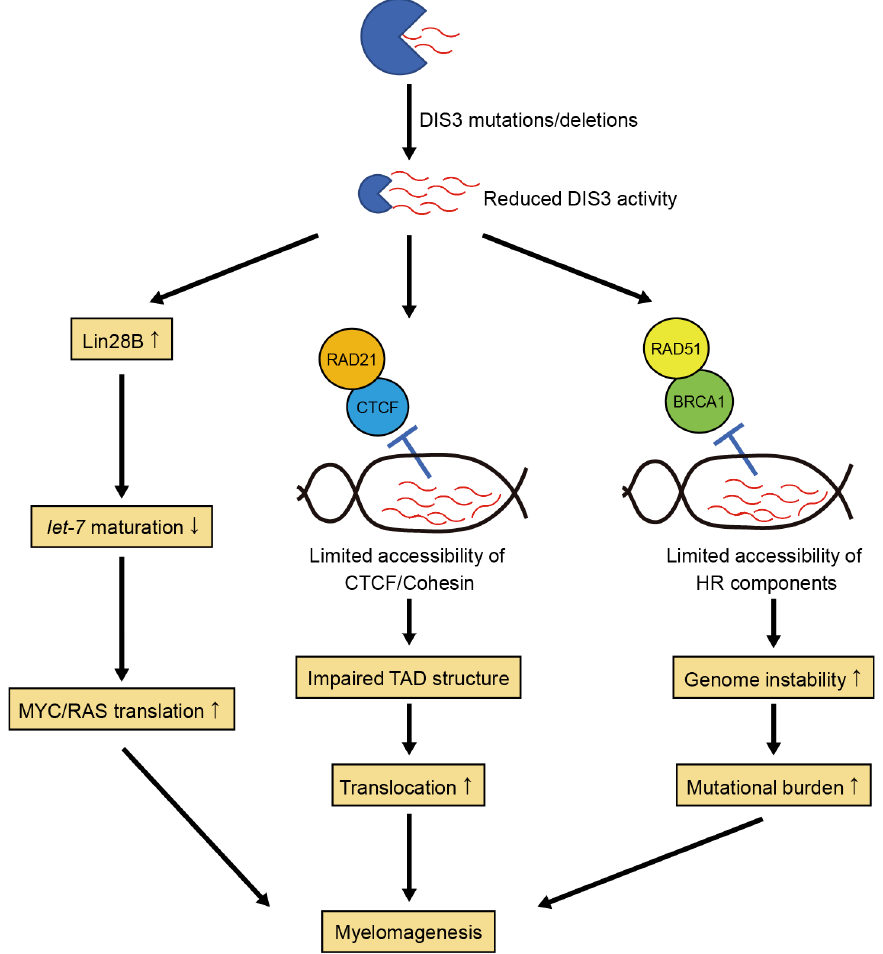
Figure 5. Potential hypomorphic functions of DIS3 in myelomagenesis. Reduced DIS3 activity increases Lin28B levels, which inhibits let-7 maturation, leading to increased MYC and RAS protein levels. Reduced DIS3 activity also induces the formation of DNA:RNA hybrids, thereby limiting the accessibility of CTCF and cohesin complex, including RAD21. This impairs topologically associating domain (TAD) structure, resulting in chromosomal translocations. Aberrant DNA:RNA hybrids also limit the accessibility of homologous recombination (HR) components, including RAD51 and BRCA1, thereby increasing genome instability and mutational burden.